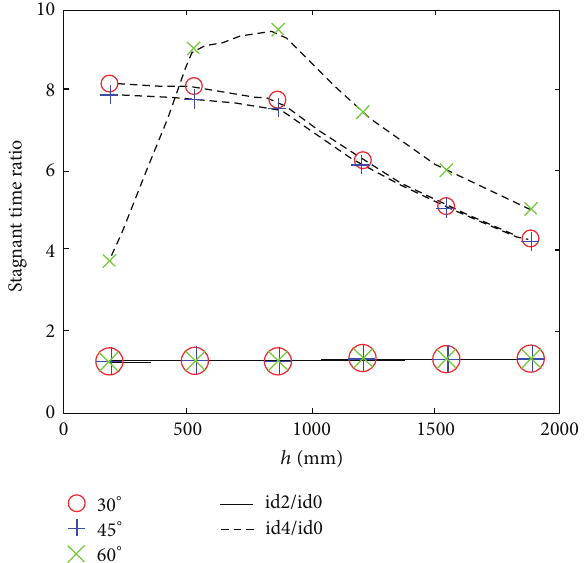
Figure 14: Simulation results about stagnant time ratio of id2, id4 to id0 in different height on the cone angles 30 ∘ , 45 ∘ , and 60 ∘ ( 𝑓 = 0.2 , ℎ = 160 d).